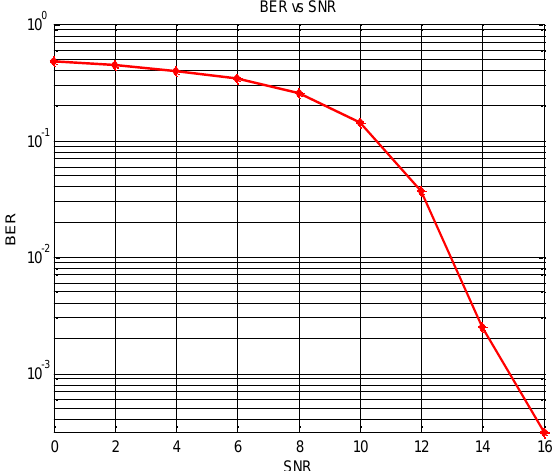
Figure 4: BER vs SNR for OFDM (number of subcarriers M=8) with 16-QAM.